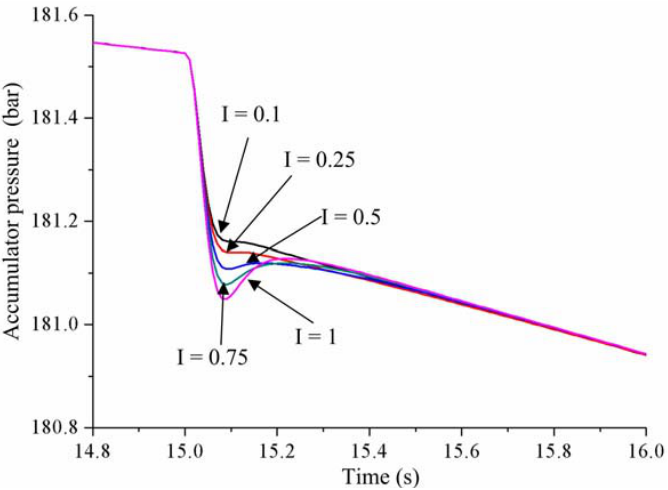
Figure 10. Simulated accumulator pressure responses of the HESGS with different integral gains.